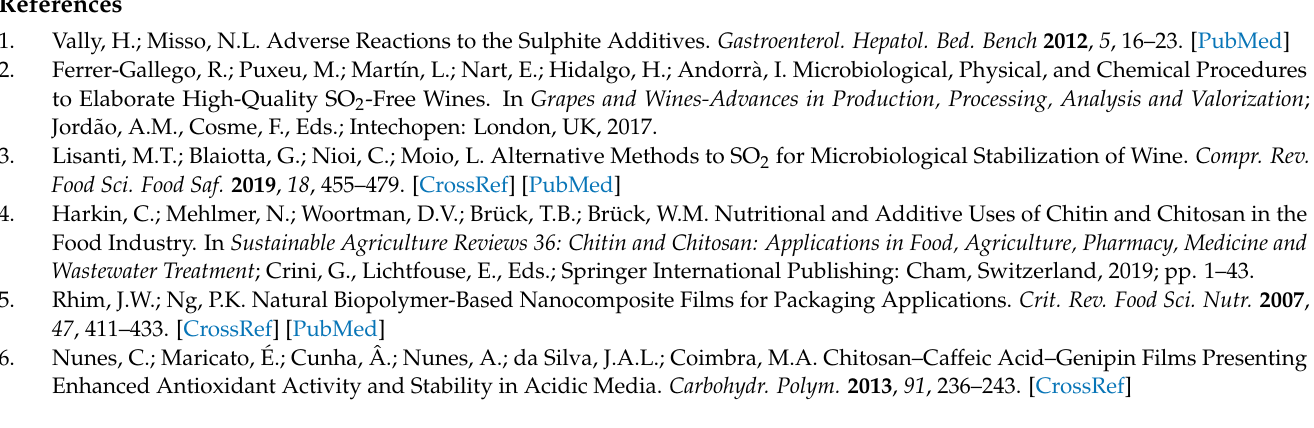
regions. Figure S2. Boxplots of varying unassigned resonances in white wines in the following conditions: untreated (Unt), treated with 40 mg/L SO 2 and treated with 25 cm 2 and 100 cm 2 Ch-Ge films, Chit25 and Chit100, respectively. Table S1. List of compounds and corresponding spin systems identified in 500 MHz 1 H NMR spectra of the white wines under study. Table S2. Summary of results obtained by one- and two-dimensional statistical total correlation spectroscopy analysis (1D and 2D